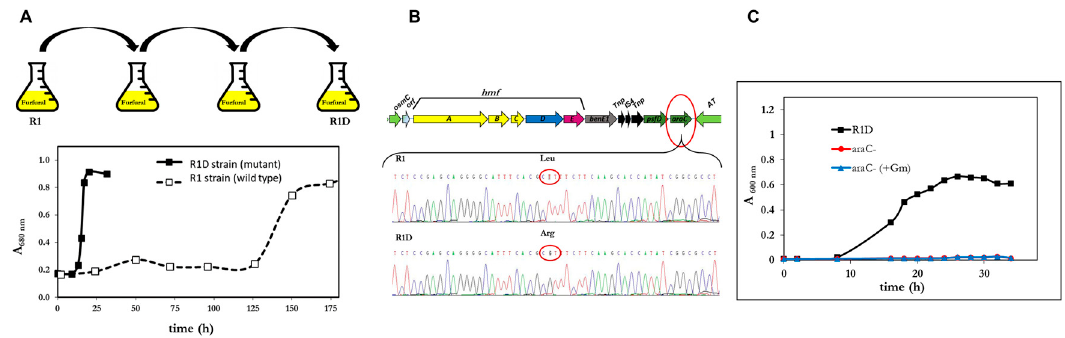
Figure 4. Role of araC in the assimilation of furfural by P. pseudoalcaligenes . ( A ) Scheme of the selection process (upper panel), and growth curve (lower panel) of the R1D mutant in comparison with the wt strain (R1), in media with furfural (10 mM) as the sole carbon source. ( B ) Scheme of the point mutation detected in the araC gene of the R1D mutant. ( C ) Growth curve of the R1D mutant and its derived mutant generated by the inactivation of the araC * gene by insertion of the gentamicin resistance gene ( aacC1 ) by double recombination. Similar results were obtained in three different experiments (panels A and C).